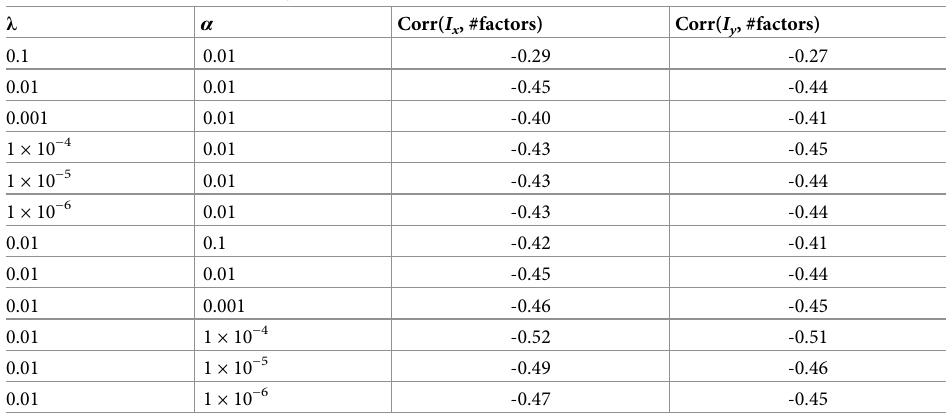
, I and the number of factors. x y